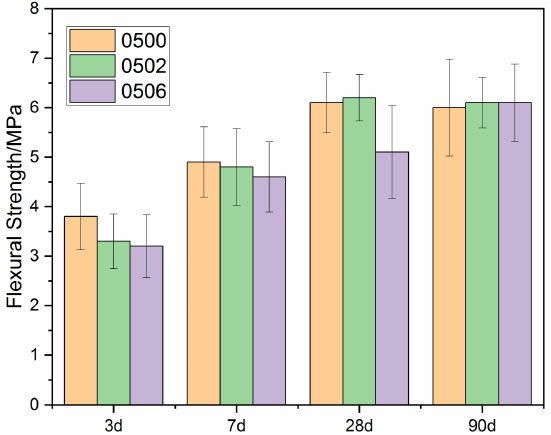
Figure 6. Flexural strength of cement paste (W/C = 0.5) with PEG-600.